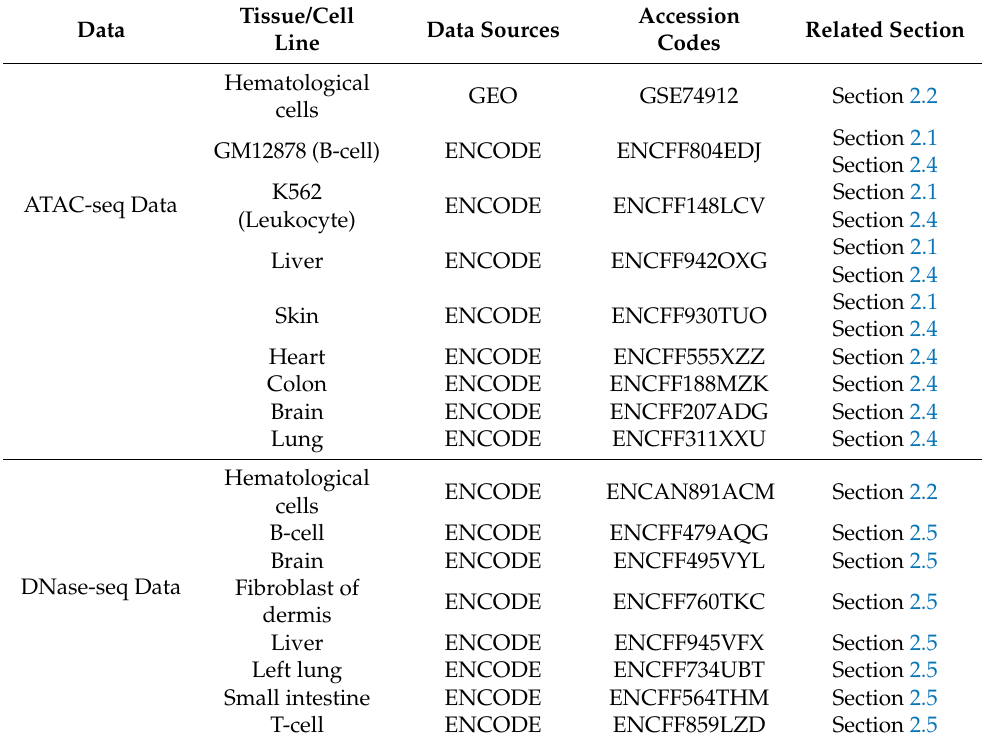
Table 1. The source of the data and the section where they were